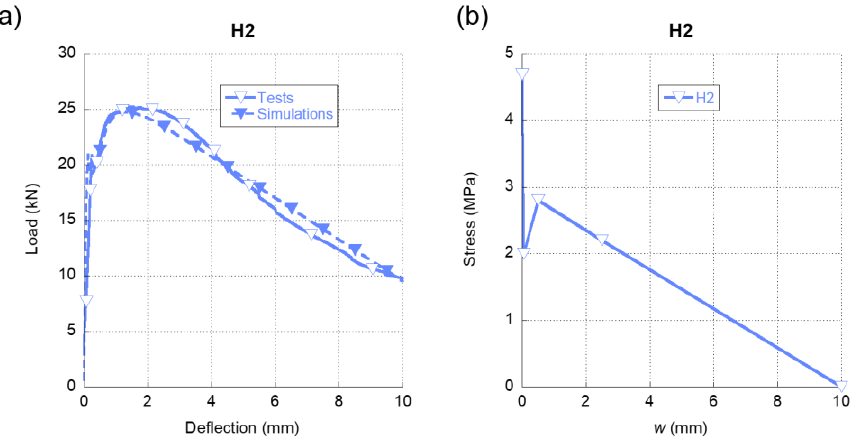
Figure 8. ( a ) Comparison of the average experimental results obtained in the fracture tests of H2 and the numerical simulation. ( b ) Softening function used in the simulation shown in ( a ).